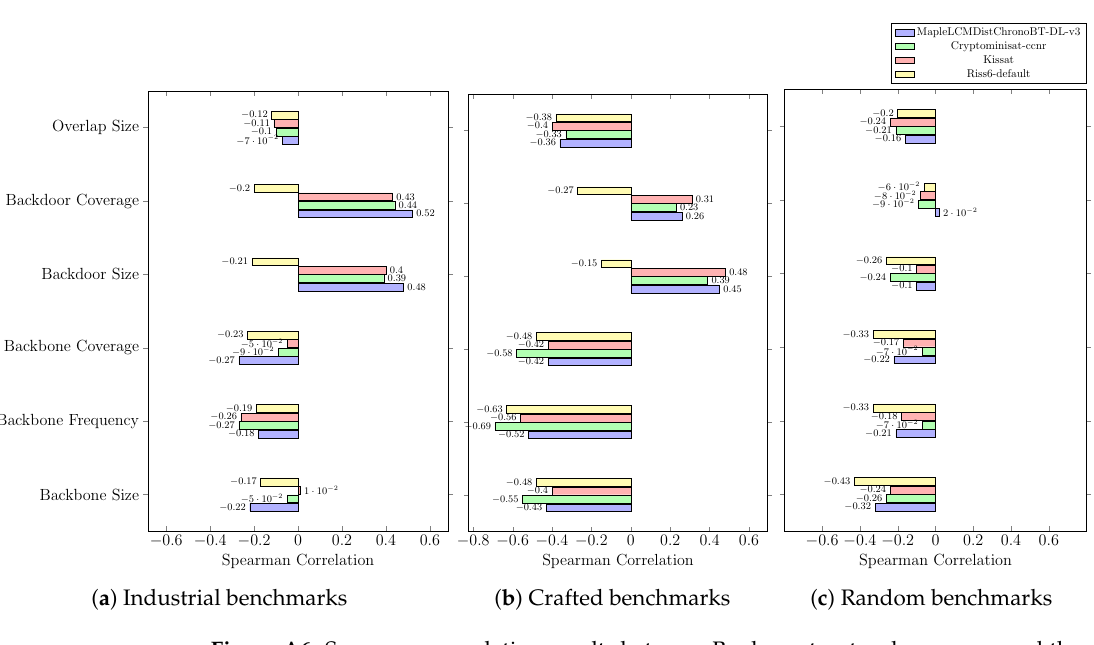
Figure A6. Spearman correlation results between Boolean structural measures and the number of propagations on 2002–2020 SAT benchmark instances.